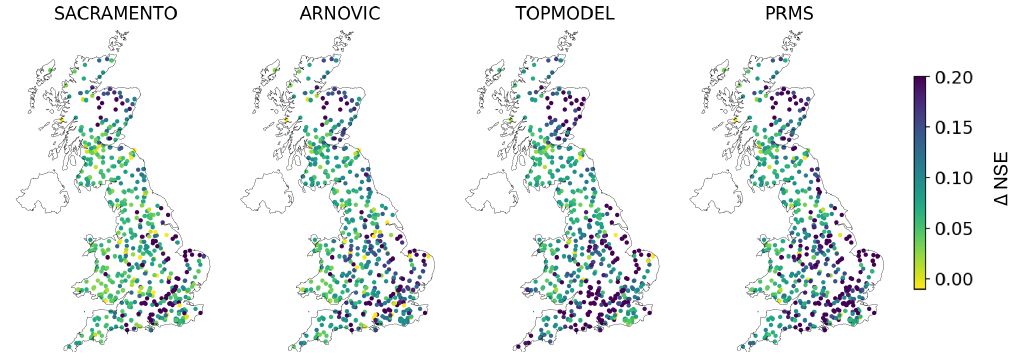
Figure 3. The performance improvement of the LSTM relative to the four conceptual models SACRAMENTO, ARNOVIC, TOPMODEL and PRMS. The difference in NSE is calculated by subtracting the conceptual model NSE from the LSTM NSE ( (cid:49) NSE = NSE LSTM − NSE conceptual ). Each point represents a station, and the colour reflects the performance improvement (measured by NSE) of the LSTM compared with the conceptual models. Positive values reflect stations where the LSTM outperforms the conceptual models.